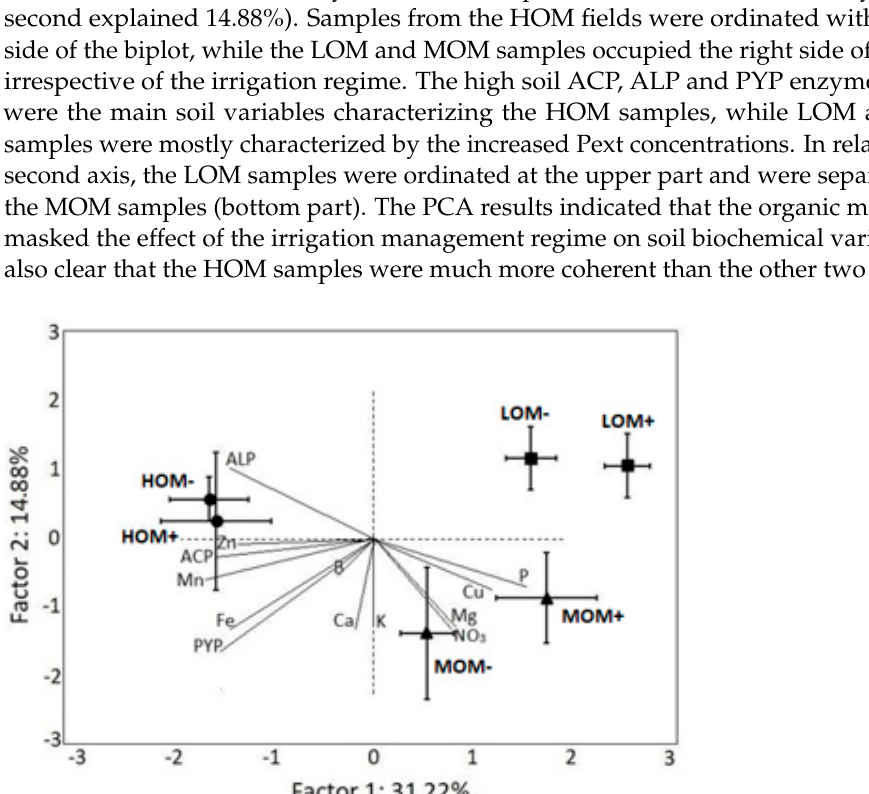
Figure 7. Ordination of the leaf samples according to the leaf nutrient variables on a PCA biplot. Each point corresponds to the mean value of the loadings of the eight samples belonging to the same treatment for the first and the second axis; the first symbol corresponds to the organic matter content (LOM: low, MOM: medium, HOM: high) and the second to the specific irrigation regime (+: irrigation, -: no irrigation). Error bars indicate standard errors for both axes ( n = 8).